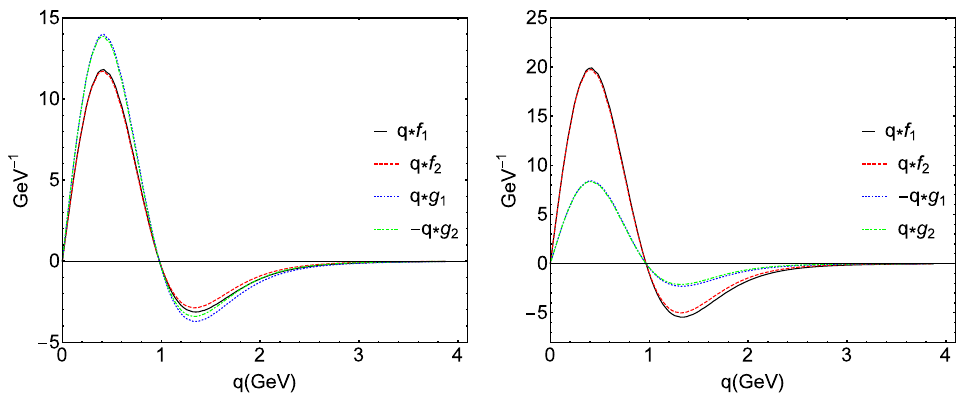
Figure 7 . The 1 + wave functions of the 2 1 P 1 − 2 3 P 1 mixing states B c 1 (2 P ) (left) and B 0 (right). f 1 and f 2 terms are 1 P 1 waves; g 1 and g 2 terms are 3 P 1